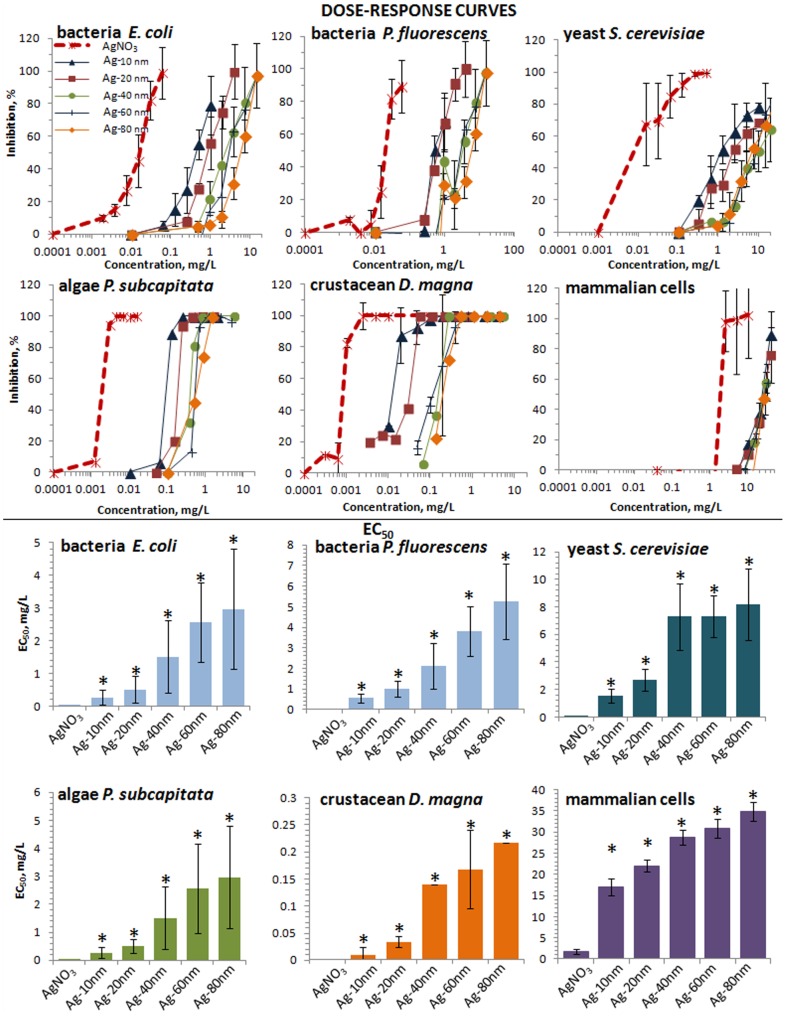
Dose-response curves and the respective EC50 values of Ag formulations to test organisms and cells.Upper panel (A–D): dose-response curves; lower panel (E–H): EC50 values. X-axis shows nominal Ag concentrations. * - significantly (p<0.05) different from EC50 value of AgNO3.